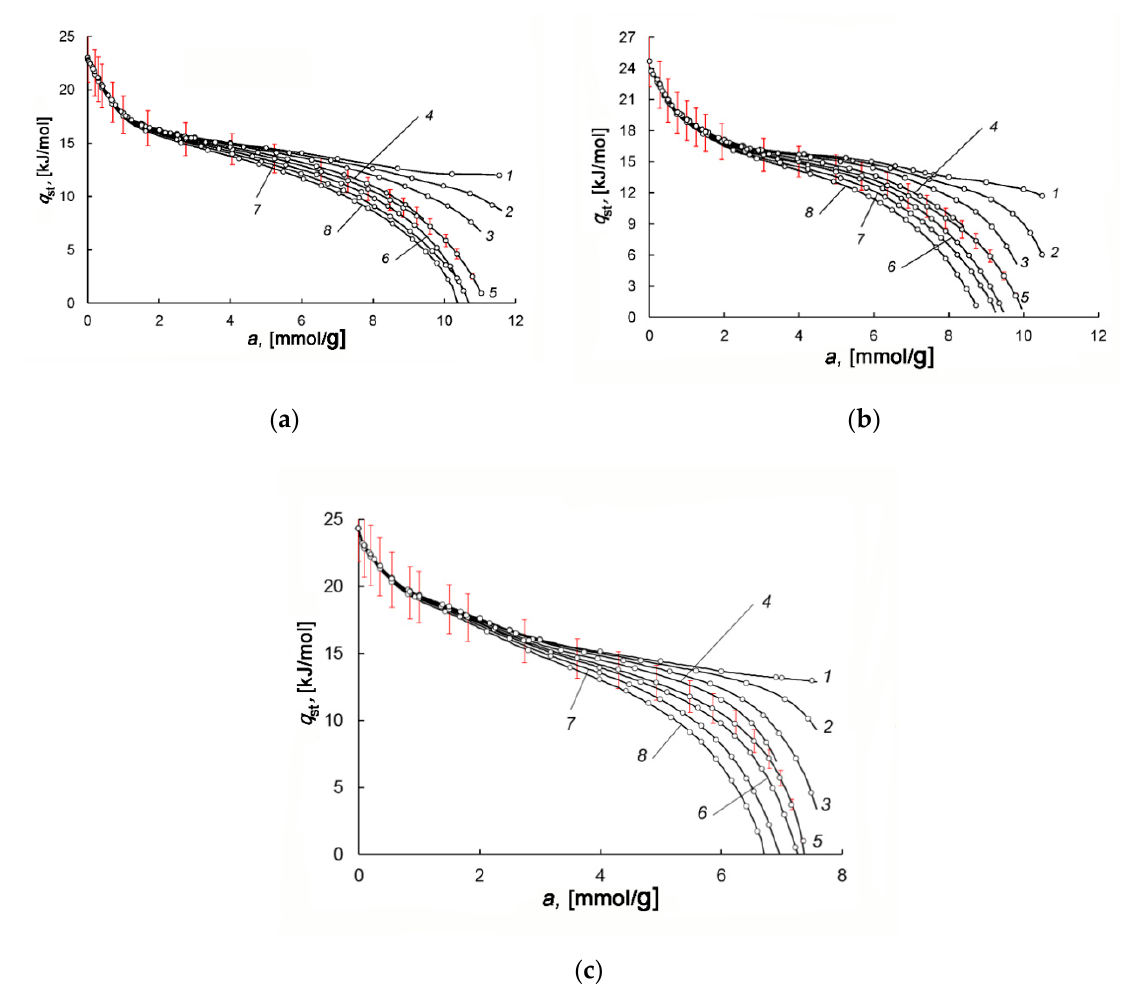
Figure 9. The differential molar isosteric heat of adsorption versus the value of methane adsorption in AC-90S ( a ), AC-90L ( b ), and AC-60L ( c ) at temperatures, K: 178 (1), 216 (2), 243 (3), 273.15 (4), 300 (5), 320 (6), 340 (7), 360 (8). Symbols show experimental data; solid curves are the results of approximation by Equation (5). The error bar is 10%.